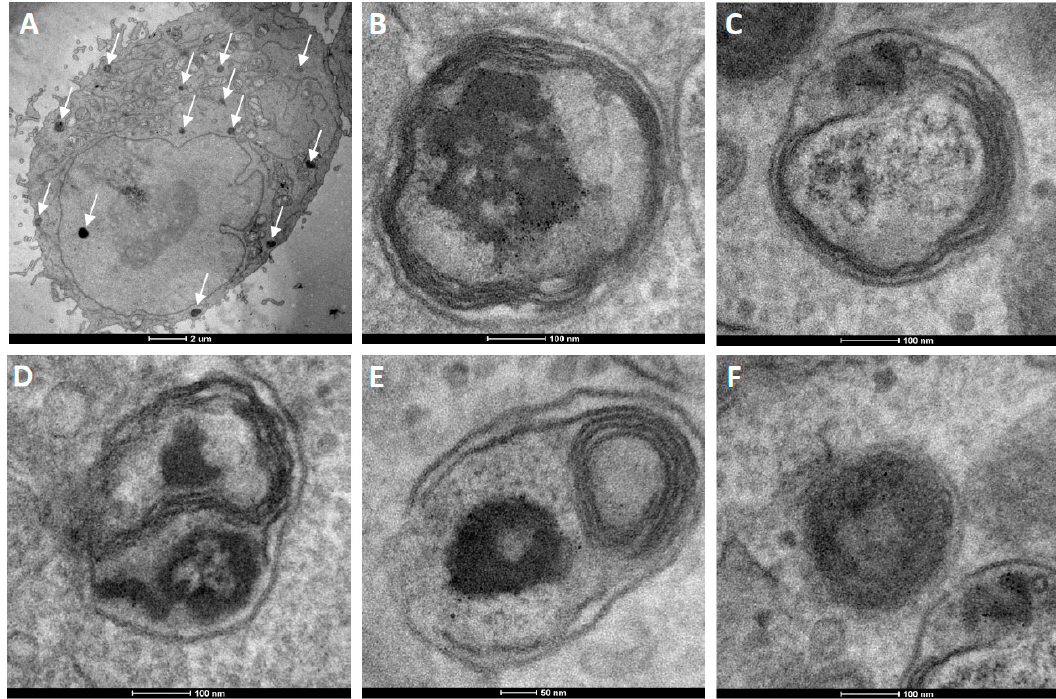
Figure 6. TEM ultrathin sections of HeLa cells after 12 h incubation with cationic fluorescent magnetopolymersomes. Vesicles (50% PBD- b -PEO-COOH; 2% DEAC) containing 10% w/w SPION were formed at 2 mg/mL via solvent inversion and subsequently coated in 10× b -PEI(800) before being purified by gel permeation chromatography. Overview in ( A ) shows elevated levels of cationically modified magnetopolymersomes taken up (black spots indicated by arrows). The sequence ( B – F ) shows higher magnification images of the apparent progression of hydrolytic degradation of SPION-loaded polymersomes after internalization.